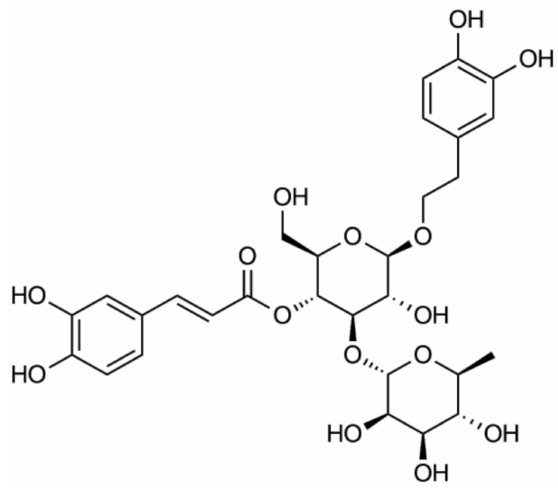
Figure 1. Chemical structure of